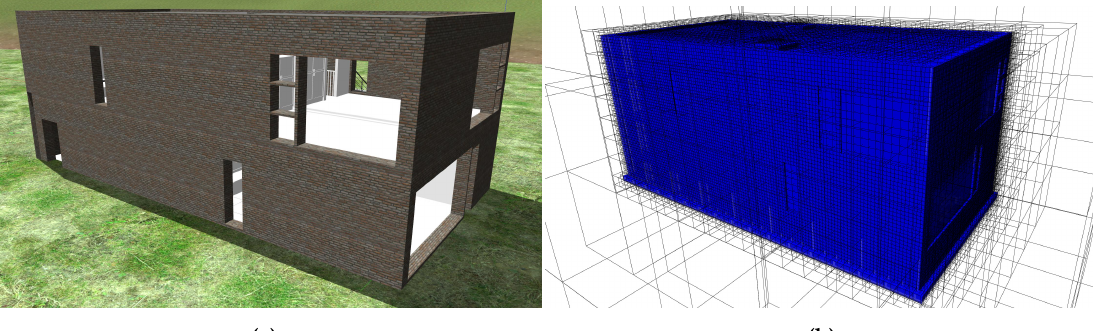
Figure 8. The octree of the building model at present state is used as a computationally efficient representation of navigation space and for the comparison of model geometry vs. reconstructed geometry. ( a ) A BIM with additional textures rendered in Gazebo for a realistic representation of the as-built state. ( b ) The corresponding octree for navigation and point cloud processing represents the as-planned